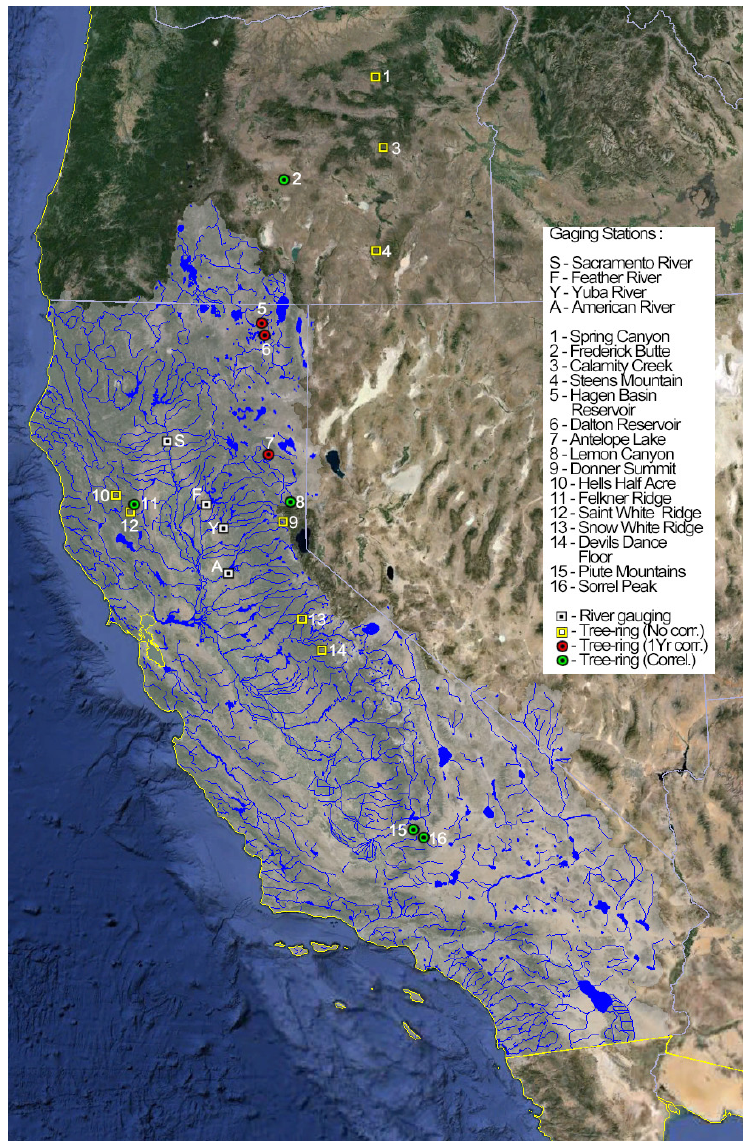
Figure 5. Study area, tree ring sites, and streamflow sites; a green circle indicates that the tree ring has correlation with streamflow, while a red circle indicates correlation with time-lag (1 year) and a yellow box indicates that there is no correlation with streamflow.